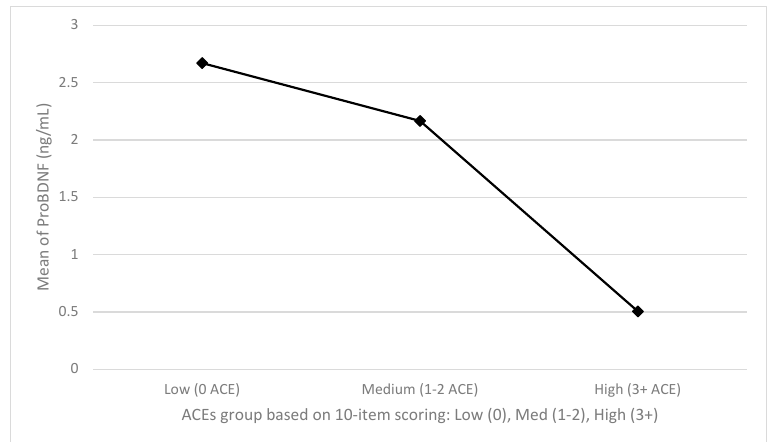
Figure 1. Levels of pro − and mature BDNF across ACEs levels.